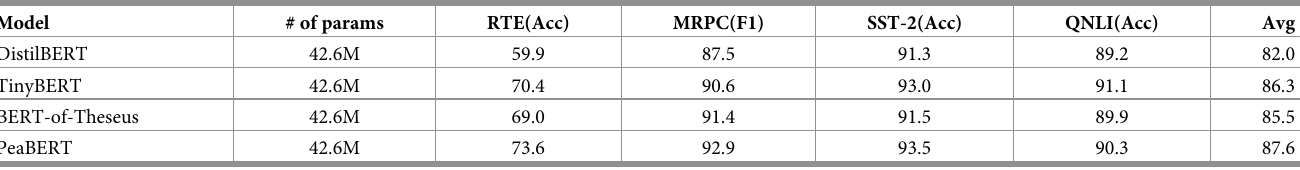
Table 3. PeaBERT in comparison to other state-of-the-art competitors.